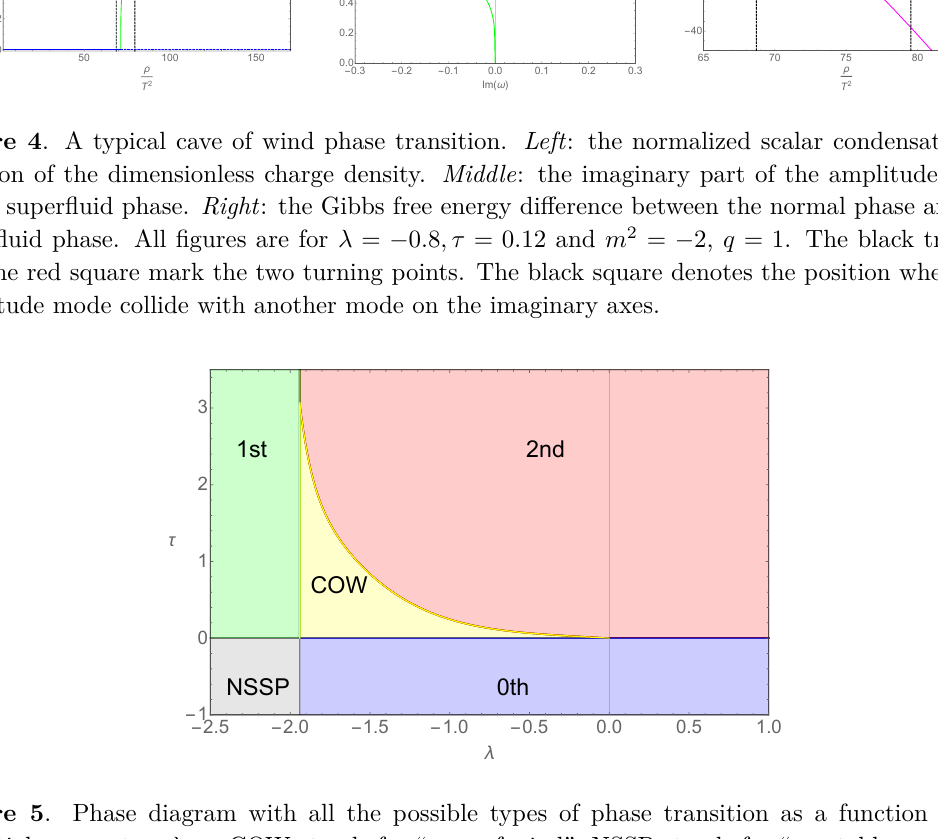
Figure 5 . Phase diagram with all the possible types of phase transition as a function of the potential parameters λ, τ . COW stands for “cave of wind”, NSSP stands for “no stable superfluid